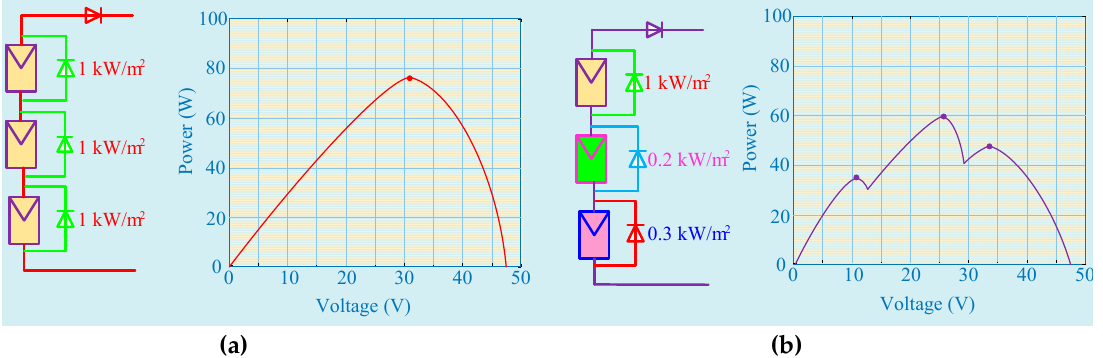
Figure 1. Partial shading conditions (PSC) effect. ( a ) Power–voltage ( P – V ) curve under uniform solar irradiation and temperature and ( b ) P – V curve under PSC.